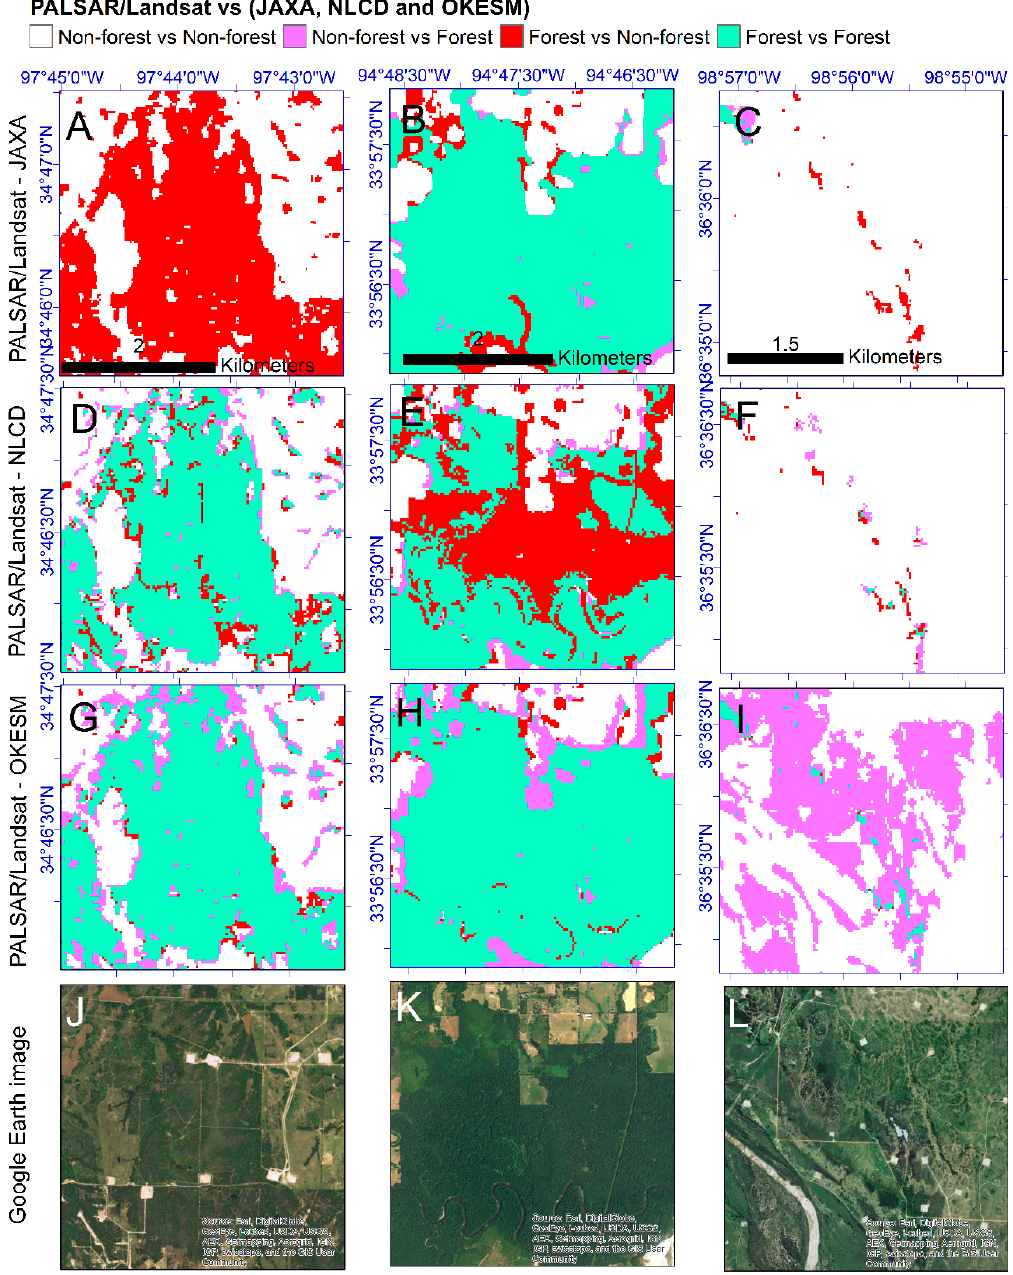
Figure 9. Zoom-in windows of the spatial comparison between the PALSAR/Landsat forest map and JAXA forest map ( A , D , G , J ); NLCD2011 forest map ( B , E , H , K ); and OKESM forest map ( C , F , I , L ) in 2010.